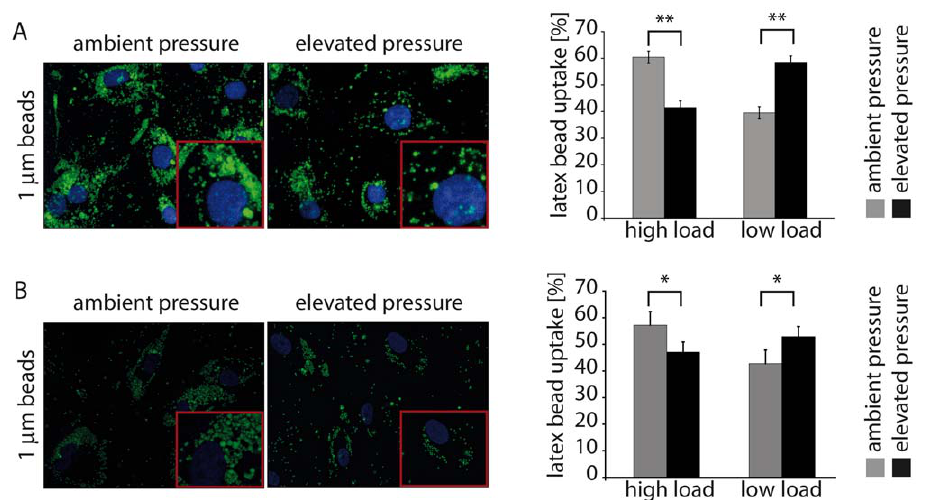
Figure 2. Endocytotic function of MECs is impacted by elevated pressure. Ben-Men-I cells (A) or PMECs (B) were treated with elevated pressure for two days and fluorescent latex beads were added to assess endocytotic activity by fluorescence microscopy ( . 100 cells scored/ condition). Ben-Men-I cells (Student’s t-test: p , 0.01, marked with ** for highly significant) as well as PMECs (Student’s t-test: p , 0.05, marked with * for significant) showed a significant decrease in endocytotic activity after pressure treatment compared to control treated cells (shown is a